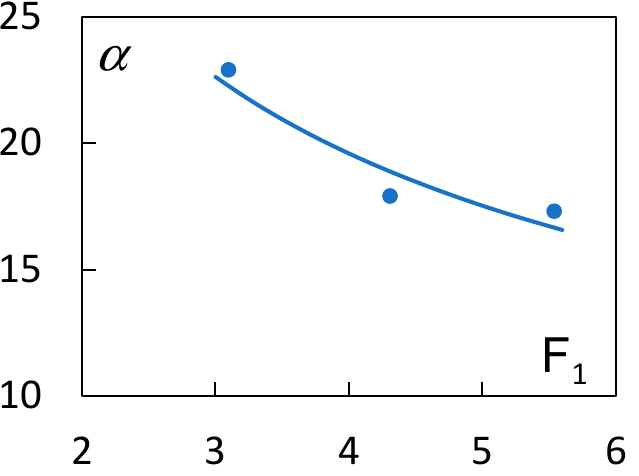
Figure 6. Relation between the forced vortex radius coefficient and the incoming Froude number.